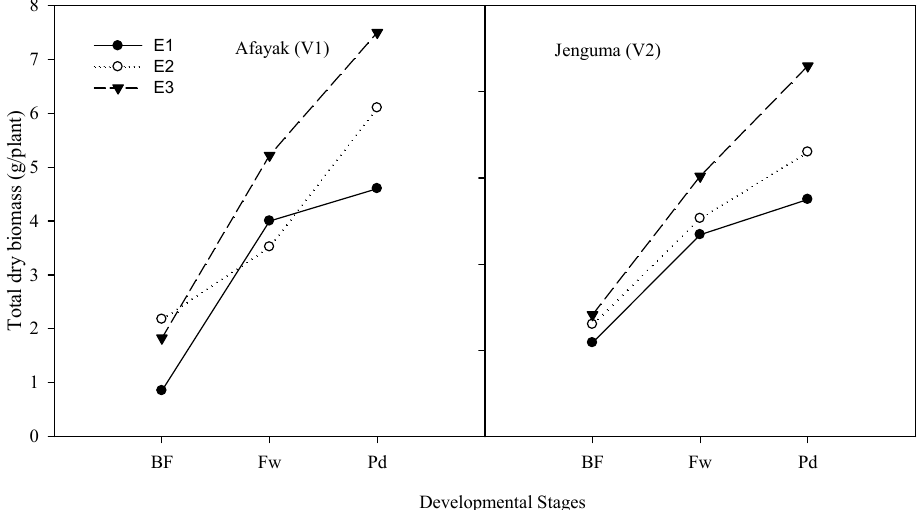
Figure 3. Environmental change on plant biomass accumulation at different developmental stages (BF, before flowering; Fw, flowering; Pd, podding) in two soybean varieties. (E1: 36 °C, RH: 55%, E2: 34 °C, RH: 57% and E3: 33 °C, RH: 44%).